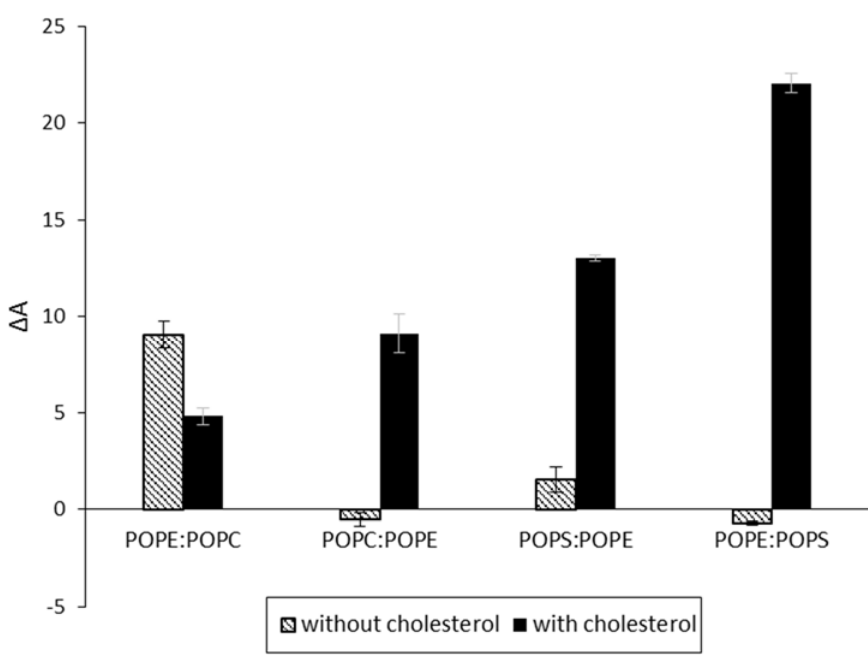
Figure 4. Percent area expansion profiles of monolayers made of different lipid combinations with/without cholesterol (black/white bars) after 3 h of CLIC1 protein injection into the subphase. CLIC1 protein showed significant insertion and/or membrane interactions in POPE:POPS monolayer containing cholesterol. ( n = 3)